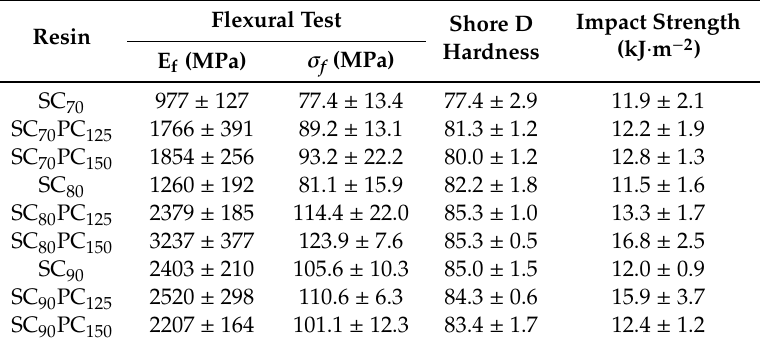
Table 2. Flexural modulus (E f ), and flexural strength ( σ f ), Shore D hardness, and impact strength of the partially bio-based epoxy resins subjected to standard curing (SC) and post-curing (PC) treatments. Flexural Test Shore D Resin